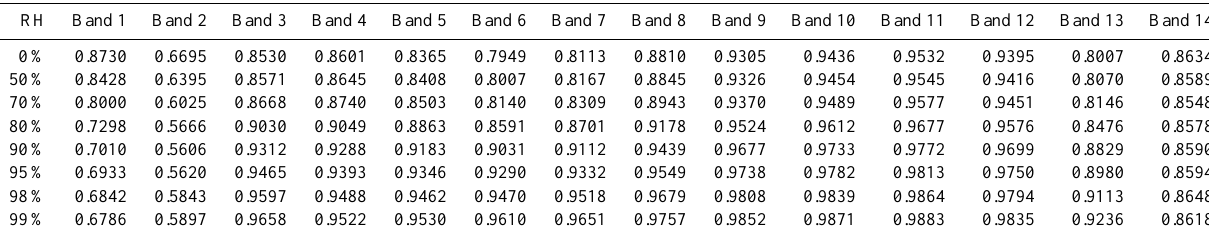
Table A3. Single-scattering albedo for the rural aerosol